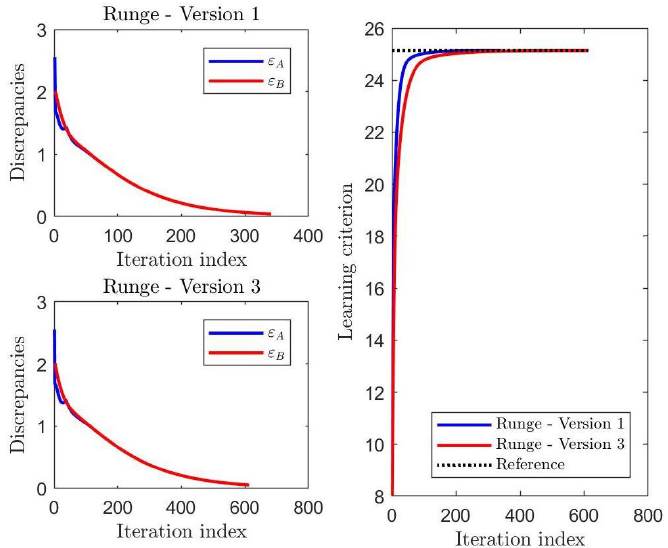
Figure 2. Results of a comparison of the values taken by the performance indexes during learning by the Runge method in its Versions 1 and